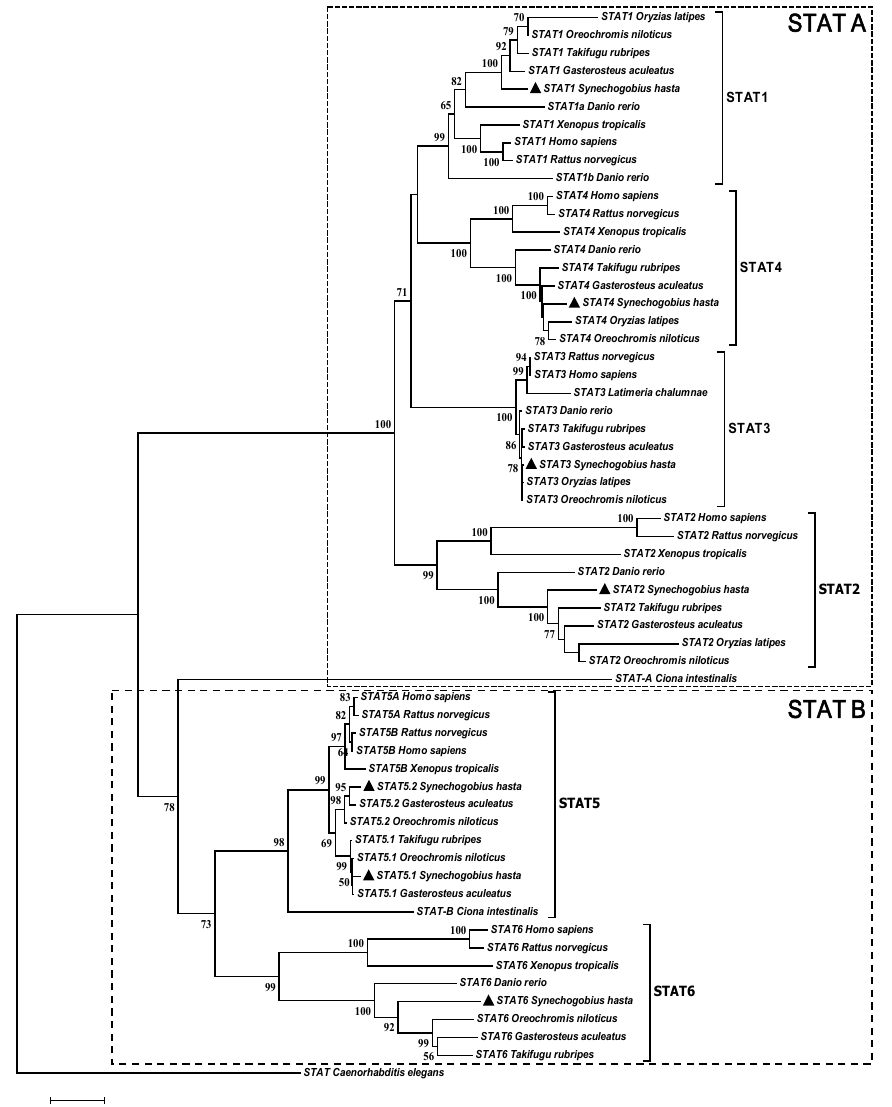
Figure 1. Neighbour-joining phylogenetic tree based on the protein sequences of signal transducers and activators of transcription proteins (STATs) from S. hasta ( ▲ ) and other species. Branch support values represent a percentage of 1000 bootstrap replicates and values lower than 50 were absent in the present analysis. Protein accession numbers are listed in Supplementary Table S1.